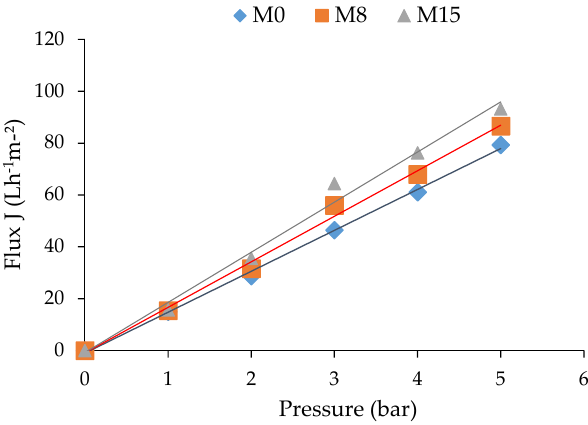
Figure 5. Water flux of the CA and CA/PAA blended membranes.